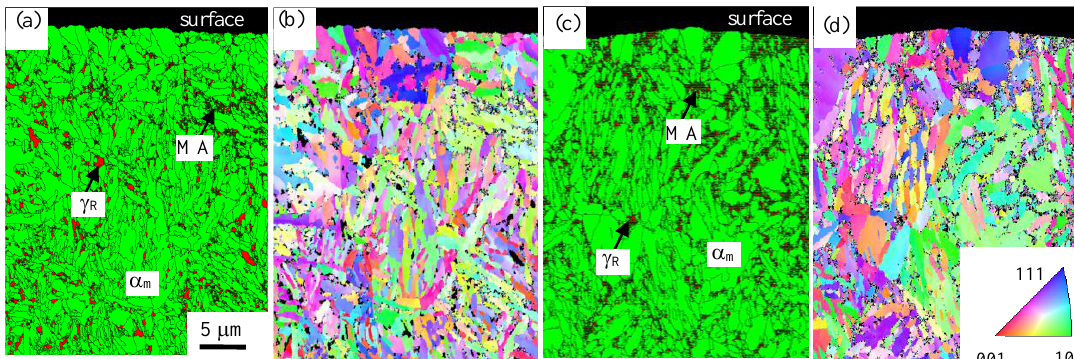
Figure 3. ( a , c ) Phase and ( b , d ) orientation maps of cross-sectional side view of surface-hardened layer Figure 3. ( a,c ) Phase and ( b,d ) orientation maps of cross-sectional side view of surface-hardened layer of the smooth specimens of as-vacuum carburized ( a , b ) TM and ( c , d ) SNCM420 steels. Yellowish green, of the smooth specimens of as-vacuum carburized (a,b) TM and (c,d) SNCM420 steels. Yellowish gray, and red regions represent α (cid:48) -martensite matrix ( α m ), MA-like phase (MA), and retained austenite green, gray, and red regions represent  ′-martensite matrix (  m ), MA-like phase (MA), and retained ( γ R ) phases, austenite (γ R ) phases, respectively.